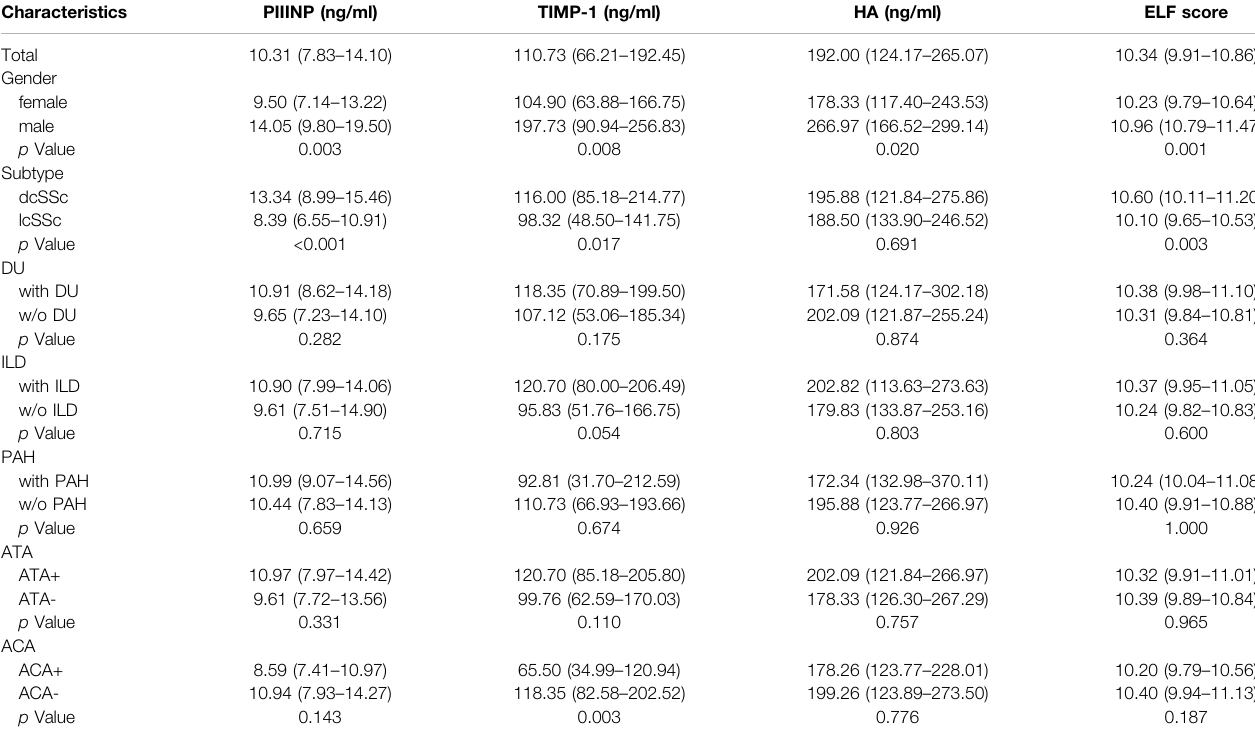
TABLE 2 | Serum PIIINP, TIMP-1, HA levels and ELF score in patients with SSc strati fi ed by main clinical characteristics. Characteristics